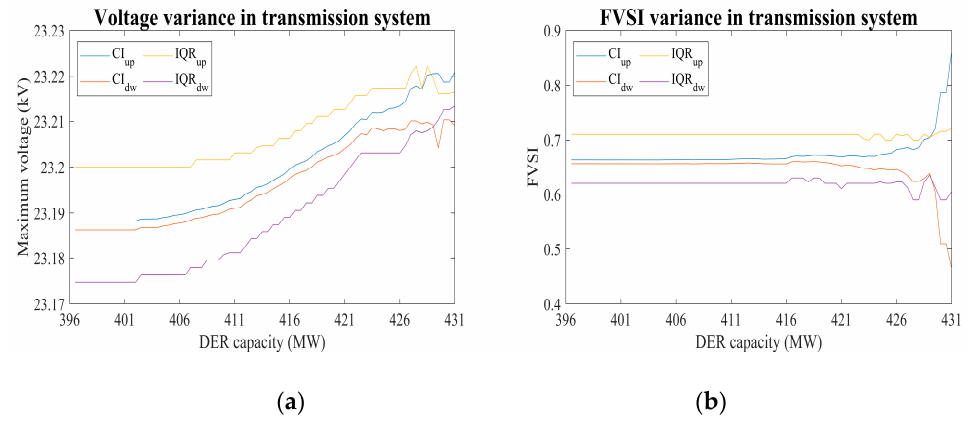
Figure 9. Result for the transmission system. ( a ) voltage variance, ( b ) FVSI variance.